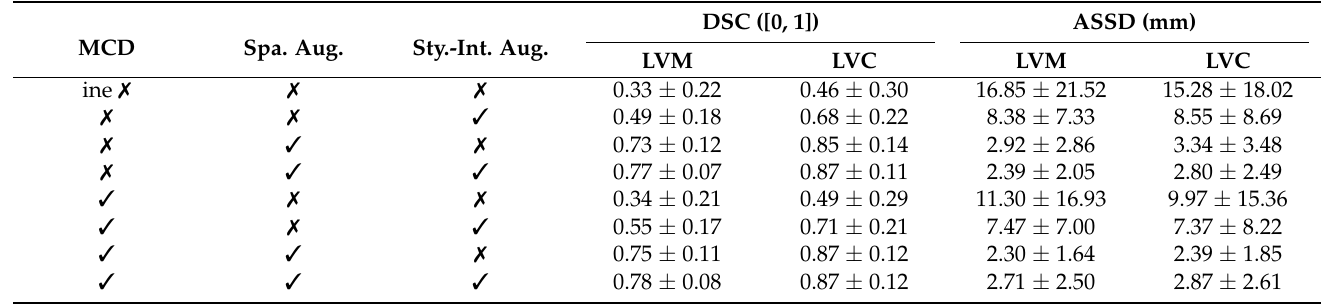
Table A1. Effects of Monte-Carlo dropout, spatial augmentation, and style-intensity augmentation on U-net training using the LVSC dataset. The three components were combined during U-net training (optimal implementation) and the trained U-net models were directly applied to the 90 ACDC test subjects ( n = 180 images) for DSC and ASSD (mean ± SD) calculation.